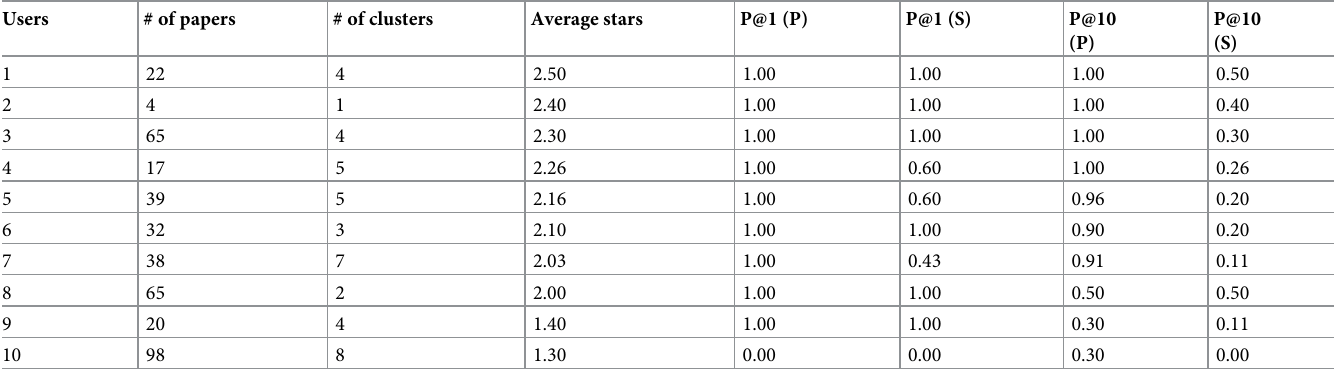
Table 7. External evaluation of our proposed